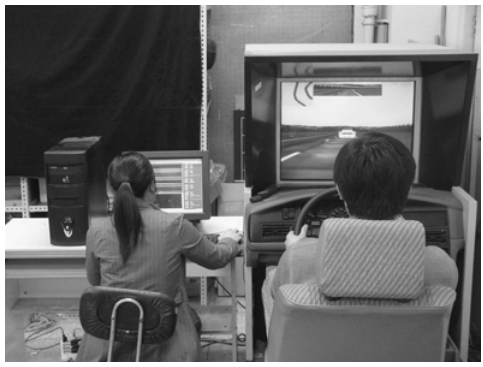
Fig. 1. Experimental platform infrastructure